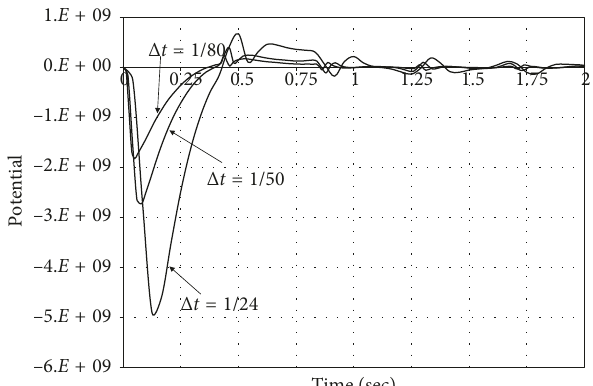
Figure 5: B-spline impulse response functions of the rigid sphere for B-spline excitations of three different durations.